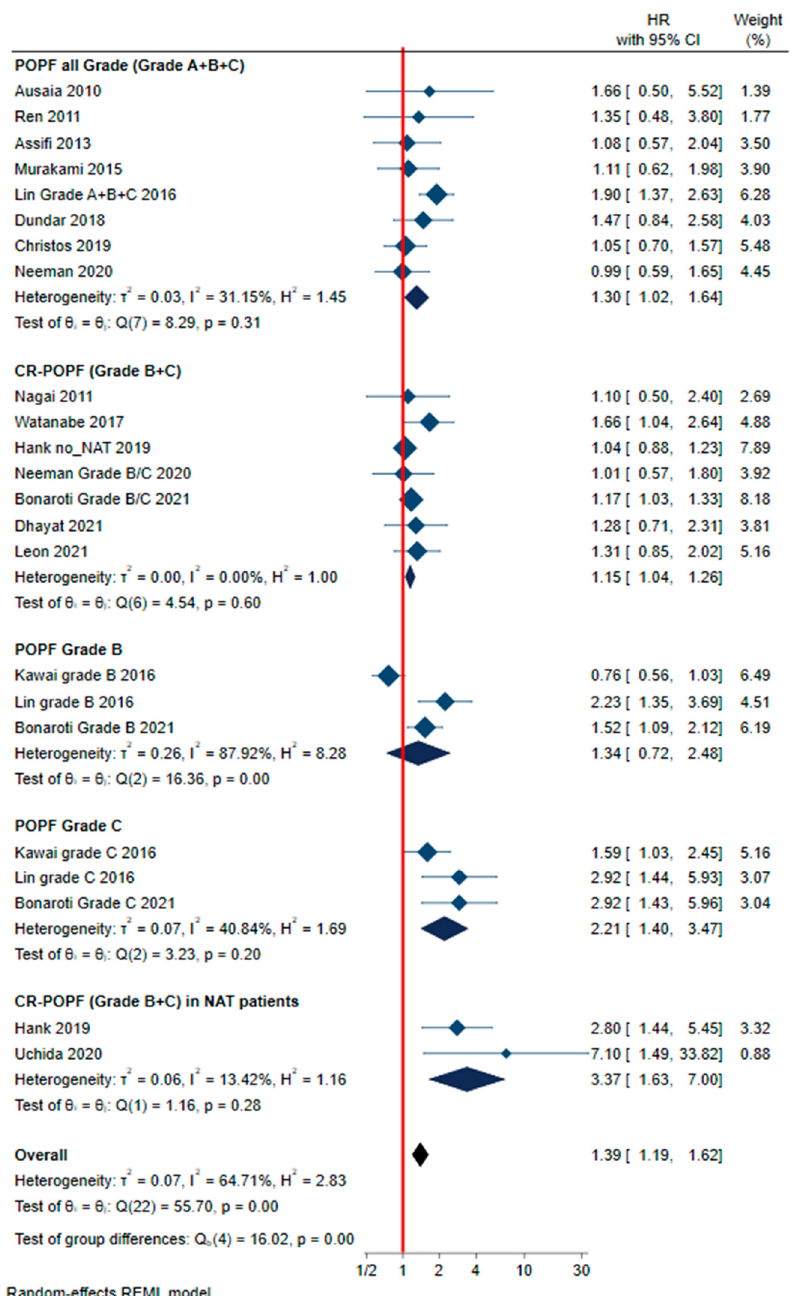
Figure 3. Forest plot summarizing the meta-analysis to compare overall survival in patients with and without postoperative pancreatic fistula (POPF), clinically relevant POPF (CR-POPF), grade-B POPF, grade-C POPF, or CR-POPF in patients who underwent neoadjuvant therapy. HR: hazard ratio; 95% CI: 95% confidential interval.